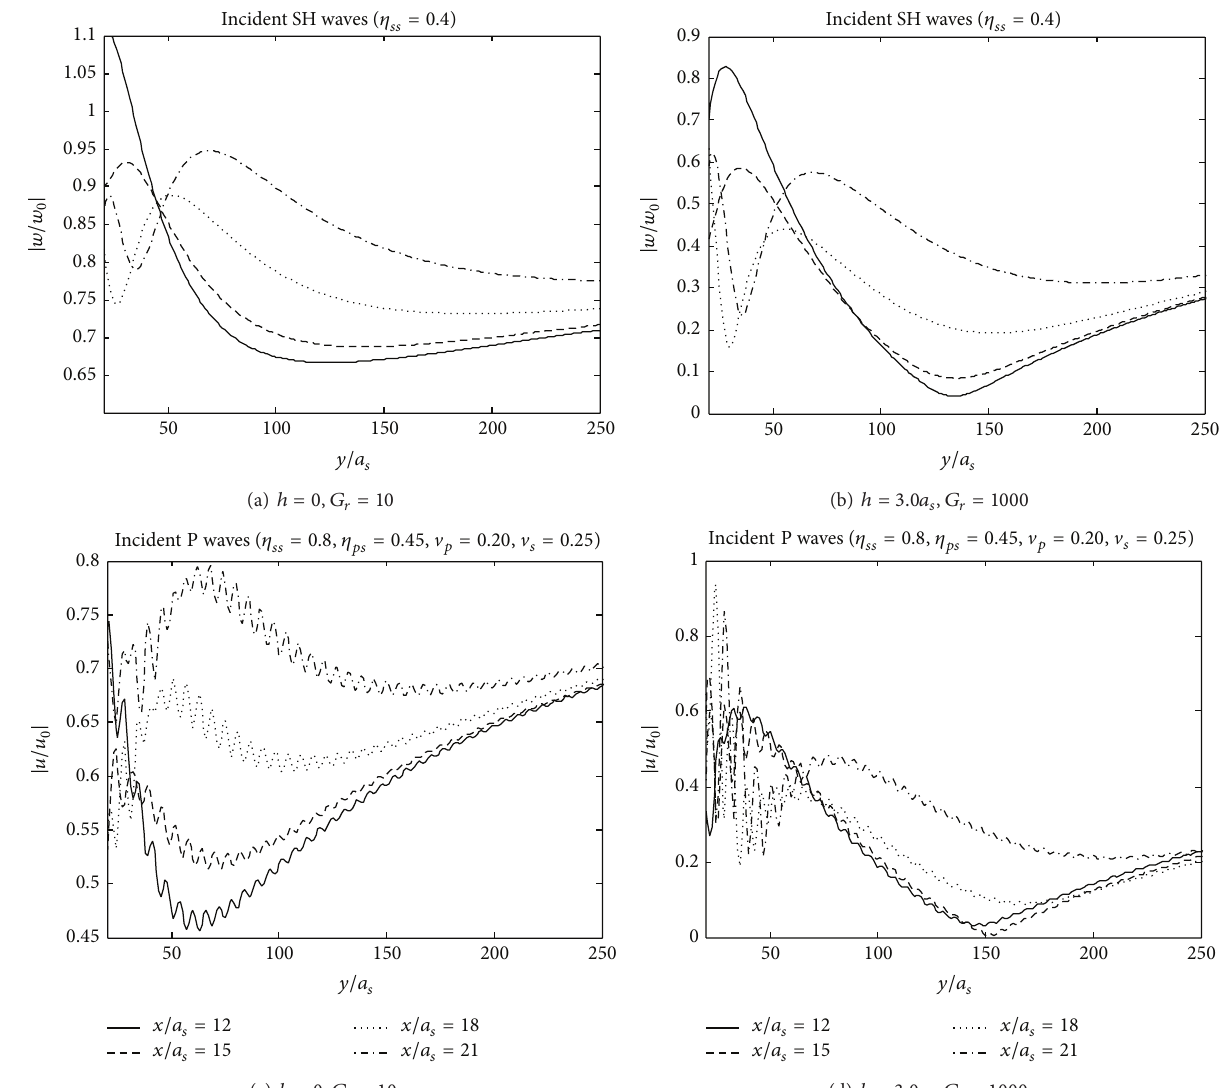
Figure 4: Normalized displacement amplitudes at different positions behind the barrier ( 𝑠 𝑝 = 3.0𝑎 𝑠 , 𝑏 𝑠 = 0.9𝑎 𝑠 , 𝑚 = 4 , 𝑁 = 8